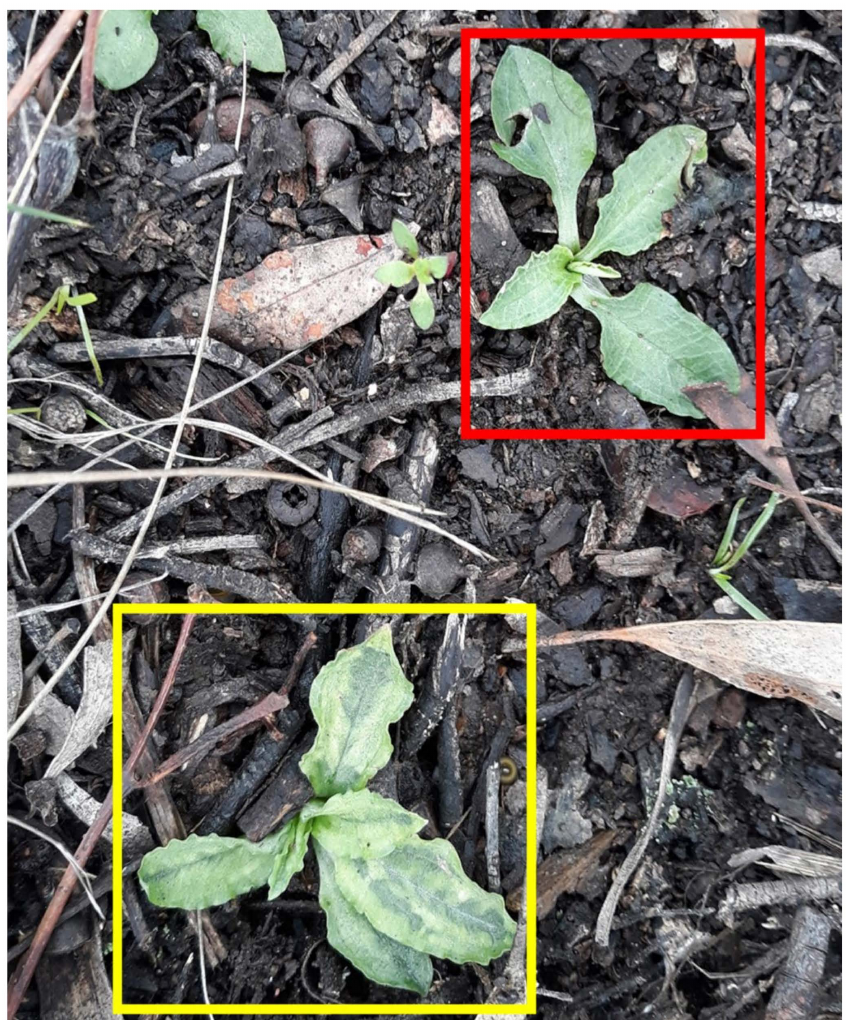
Figure 1. Pterostylis nutans infected with Pterostylis blotch virus (yellow frame) and healthy P. nutans (red frame), on Black Mountain, the Australian Capital Territory, in